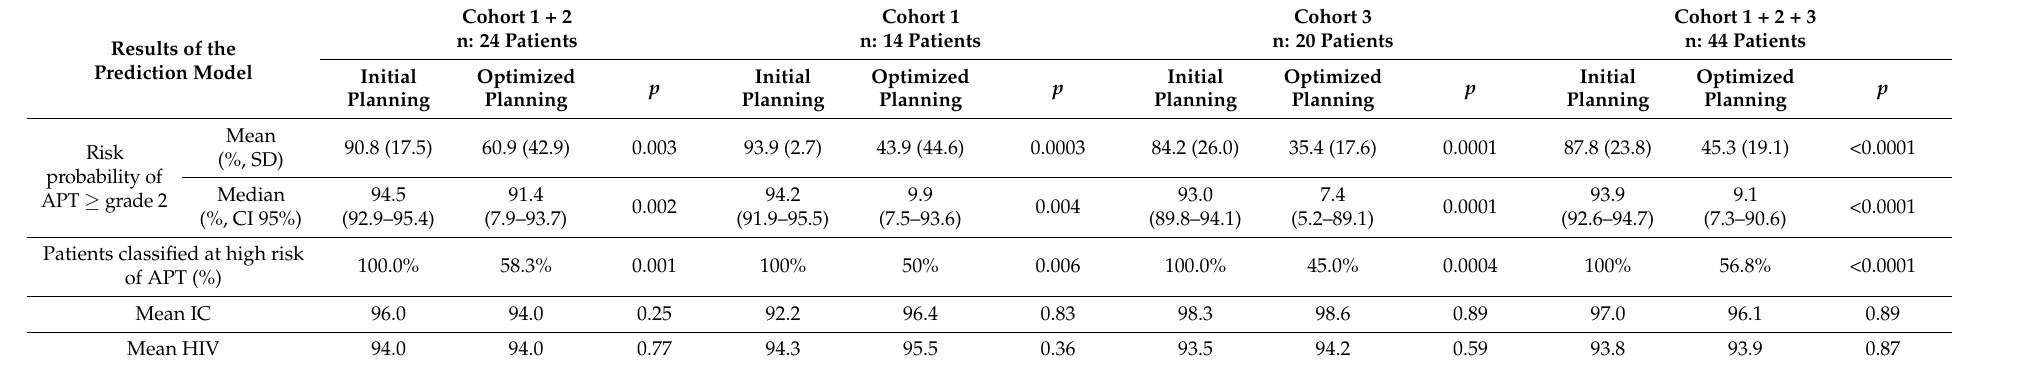
Table 2. Results of the prediction model based on the initial and optimized plannings in each